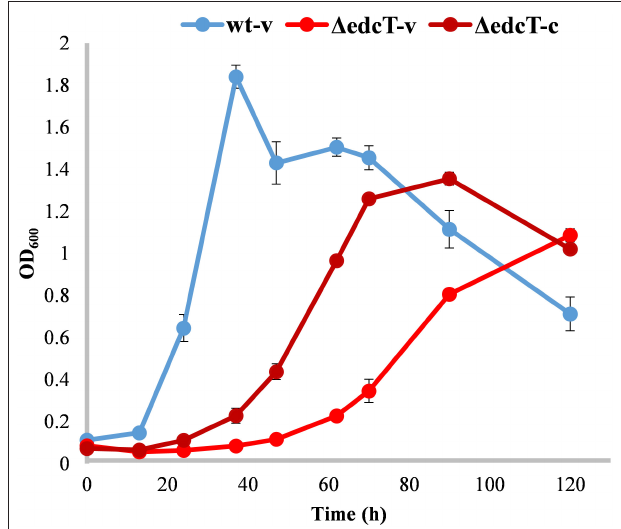
FIGURE 14 | Growth curves (OD 600 ) of N. tardaugens on M63 minimal medium supplemented with 2mM E2 of NBRC 16725 and 1 edcT harboring the pSEVA23PlexA plasmid, (-v), and complemented with the deleted gene, (-c). Data corresponds to biological triplicates and error bars show standard